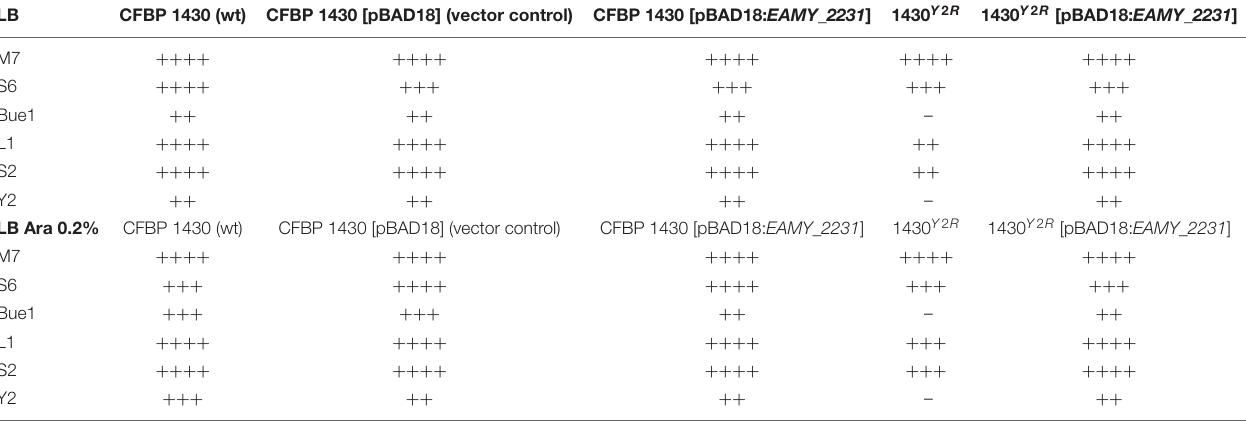
TABLE 2 | Plaque formation of six phages on the generated mutants – symbolizes no plaque formation.